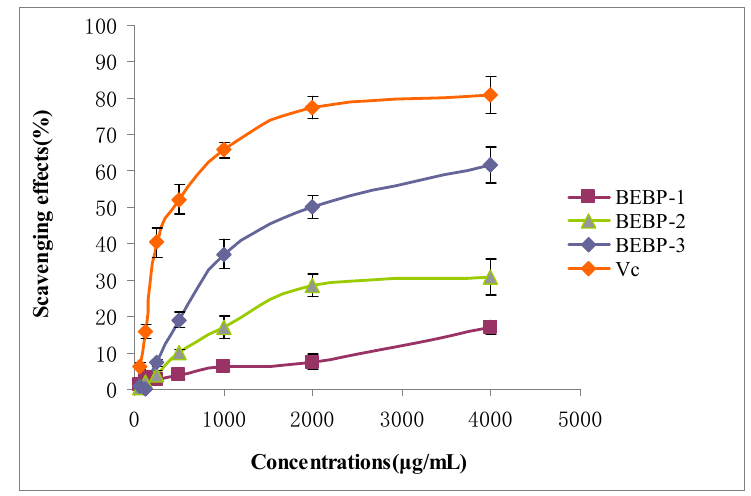
Figure 2. The scavenging effects of different polysaccharide fractions on hydroxyl radical. Results are presented as means ± standard